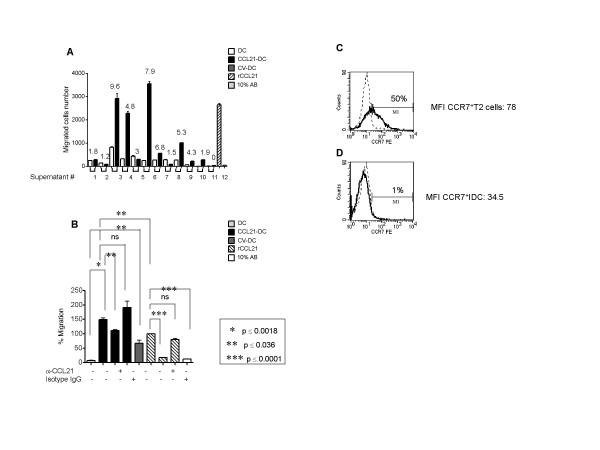
Supernatants from CCL21-DC stimulate chemotaxis of T2 cells. (A) The supernatants from DC, CCL21-DC and CV-DC from different individuals (n = 12) were utilized in a standard chemotaxis assay to assess their ability to induce chemotaxis of T2 cells. Briefly 2.0 × 105 T2 cells were loaded in the upper chamber of a 24-well transwell apparatus and allowed to migrate through a 3 μm insert for 2 and 1/2 h at 37°C. In A, the lower chambers of the transwell had been loaded with the supernatant from DC or CCL21-DC (supernatant #1–11) from the same individual, or DC or CV-DC (#12) from the same individual, as indicated. Recombinant CCL21 (600 ng/ml) and 10% AB medium were added to the wells as positive and negative controls, respectively. A summary of chemotaxis from 12 different samples is shown. The CCL21 protein concentration in ng/ml is indicated over each column. Migrated cells were analyzed by flow cytometry by counting the number of events per minute (expressed as migrated cell number) within a pre-determined T cell gate. One-way ANOVA p < 0.0001. In blocking experiments (B), the supernatants from CCL21-DC or recombinant CCL21 were pre-treated with a neutralizing concentration of anti-CCL21 antibody (1.5 μg/50 ng CCL21) or isotype immunoglobulin, prior loading in the lower chamber of the transwell apparatus. The supernatant from CV-DC and medium containing 10% AB were also assessed. To determine total T2 cell migration, T2 cells were loaded without inserts. A representative experiment of a total of seven is shown. The number of migrated cells was analyzed by flow cytometry as above, and is expressed as percentage of total T2 cell migration. Asterisks denote statistical significance (p < 0.05). The surface expression of CCR7 is analyzed by flow cytometry in T2 cells (C) and in immature DC (D) cultured for 6 days in GM-CSF and IL-4. Histograms are shown: dotted lines indicate isotype control, bold lines indicate marker expression. The percentage of positive cells and MFI are indicated. A representative experiment of two is shown.